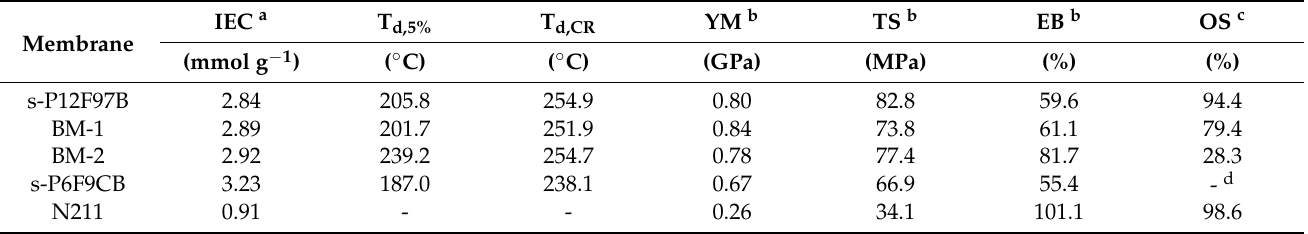
Table 1. Thermal stability and mechanical properties of the ionomers and blend membranes.